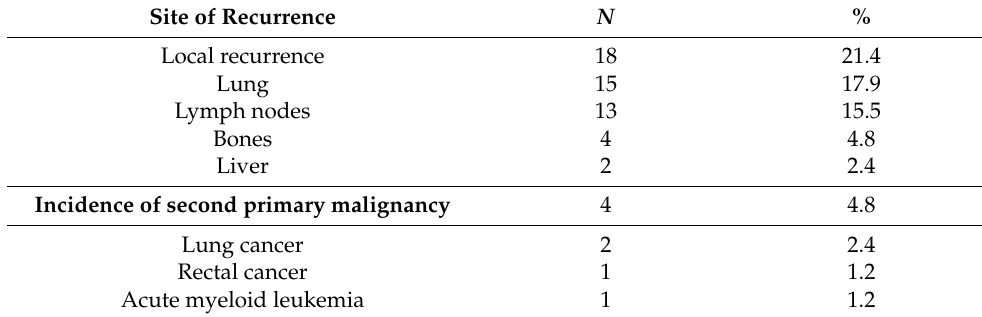
Table 2. Disease recurrences and second primary malignancies in all patients, N =